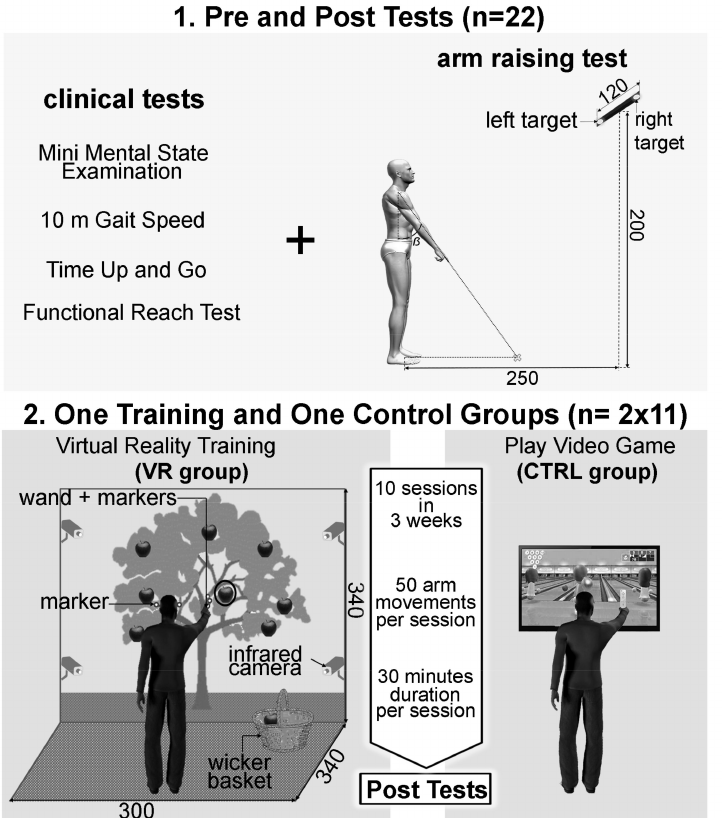
Figure 2. This figure summarizes the whole experimental design. Panel 1: overview of all the tests used to measure the rehabilitation training effects. On the left side of Panel 1 are the clinical tests used, and on the right of Panel 1 are the experimental set-up and apparatus of the arm-raising test used to evaluate the neural mechanisms of the motor control during voluntary arm-pointing movements. Here the participant maintains the standardized initial starting posture. The distances are reported in centimetres, and the SS angle measures 35 ◦ . Panel 2: overview of the whole rehabilitation training phase, for both experimental groups. On the left of Panel 2 are the virtual reality set-up and apparatus used for the VR group. As in Panel 1, distances and dimensions are reported in centimetres. On the right of Panel 2 is the training set-up with a ‘Nintendo Wii’ used for the CTRL group. Between these two halves of Panel 2, the duration of the rehabilitation training phase, the number of movements by session, and the duration per session are reported. These parameters of the rehabilitation training phase were similar for both the VR and CTRL